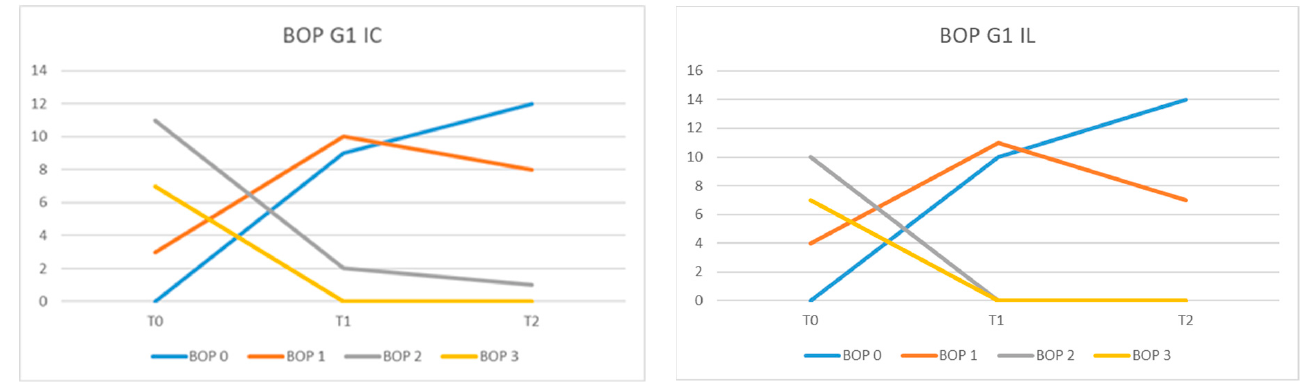
Figure 6. BOP values in group G1 Il and G1 IC at moments T0, T1, and T2.